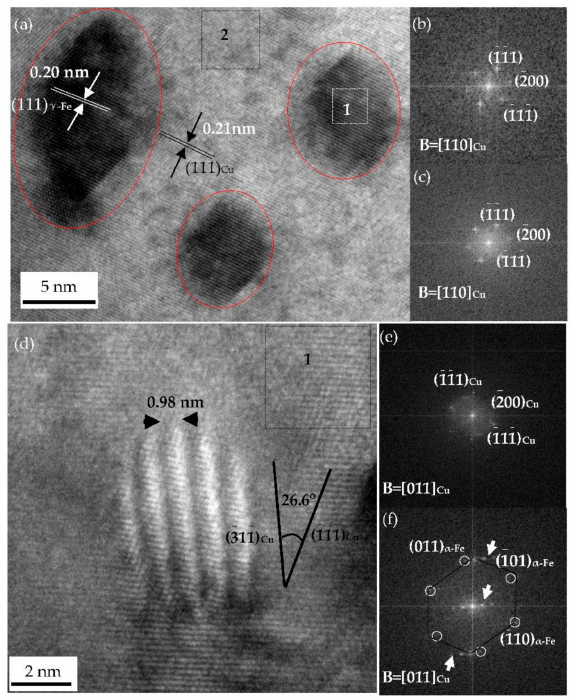
Figure 5. HRTEM and Cs-corrected STEM micrographs of γ -Fe nanoparticles in as-cast Cu-10Sn-2Zn- 1.5Fe-0.5Co alloy and their FFT patterns: ( a ) HRTEM micrograph of iron-rich nanoparticles when the incident electron beam is parallel to <110> Cu ; ( b , c ) FFT patterns of position 1 and 2 in ( a ), respectively; ( d ) HRTEM image of a single iron-rich nanoparticle taken from the specimen. Zone axis: [011] Cu ; ( e ) Diffractogram taken from position 1 in ( d ); ( f ) Diffractogram taken from the HRTEM image of ( d ), where FFT pattern of Cu matrix and iron-rich nanoparticle are indicated by black lines and white circles, respectively [42].